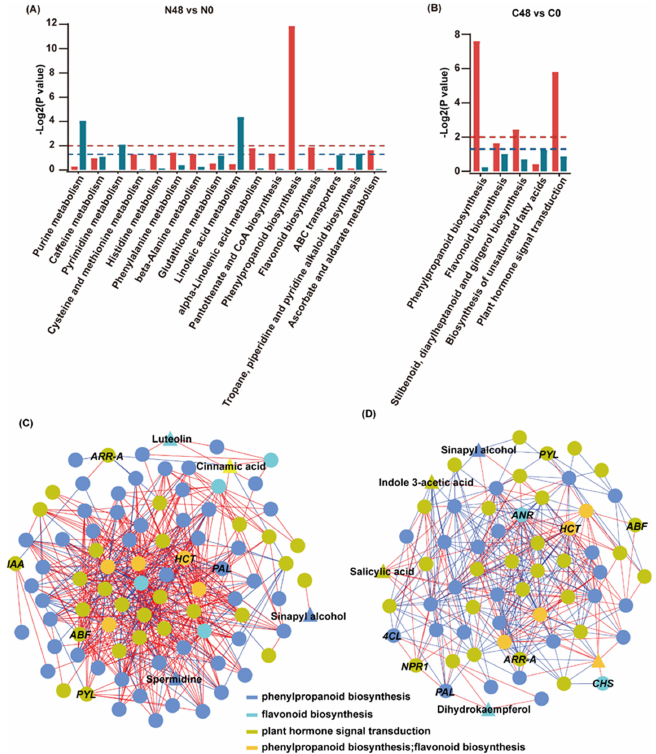
Figure 4. Correlation analysis of the transcriptomic and metabolomic data for Nipponbare and C331 under BPH stress. ( A ) KEGG enrichment analysis of the DEGs (red column) and DAMs (dark cyan column) that were enriched in the same pathway in the Nipponbare. ( B ) KEGG enrichment analysis of the DEGs (red column) and DAMs (dark cyan column) that were enriched in the same pathway in the C331. The red dashed lines represent empirical -Log2P values of 0.01, while the blue dashed lines represent empirical -Log2P values of 0.05. ( C ) The connection network between DEGs and DAMs mapped on phenylpropanoid biosynthesis, flavonoid biosynthesis and plant hormone signal transduction with the absolute value of |pearson correlation coefficient| ≥ 0.9 in the Nipponbare variety. ( D ) The connection network between DEGs and DAMs mapped on phenylpropanoid biosynthesis, flavonoid biosynthesis and plant hormone signal transduction with the absolute value of |pearson correlation coefficient| ≥ 0.9 in the C331 variety. Circle represents DEGs and triangle represents DAMs. Circles and triangles in different color indicates different pathways, dark blue represents phenylpropanoid biosynthesis, bright green represents flavonoid biosynthesis, grass green represents plant hormone signal transduction, yellow – orange represents both phenylpropanoid biosynthesis and flavonoid biosynthesis. The red line represents a positive correlation; the blue line represents a negative correlation.